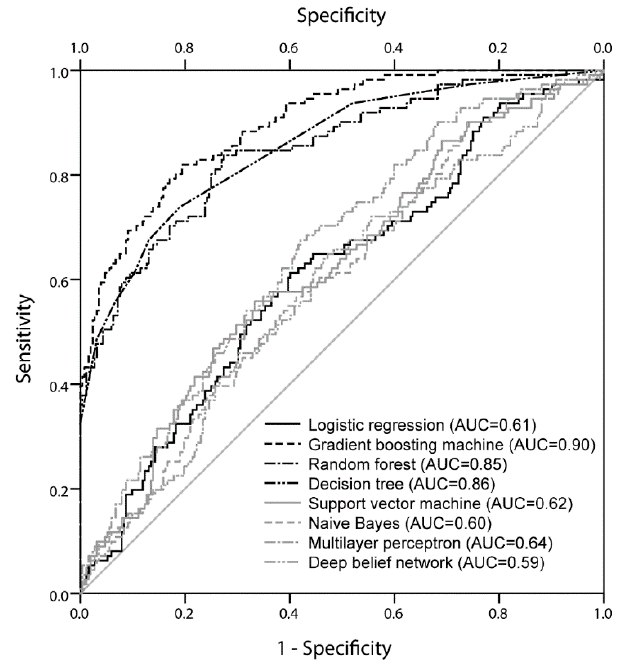
Figure 1. Comparison of area under the receiver operating characteristic curves among the machine learning models and the logistic regression model to predict acute kidney injury of all stages. AUC = area under the receiver operating characteristic curve.